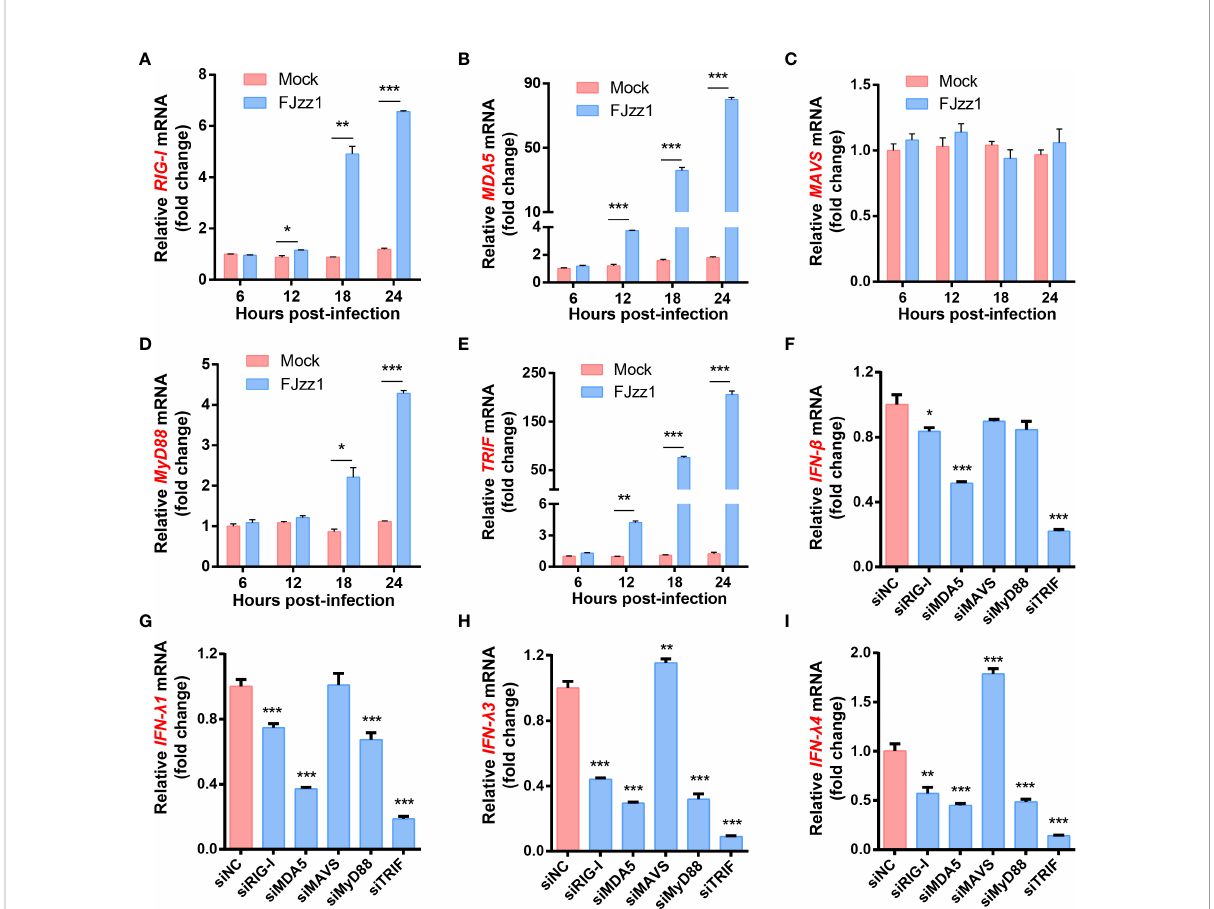
FIGURE 5 FJzz1 infection induced the production of type I/III IFNs through RLRs and TLRs signaling pathways. (A – E) FJzz1 infection increased the production of RIG-I, MDA5, MyD88, and TRIF. LLC-PK1 cells were infected with FJzz1 at an MOI of 0.01, and total cellular RNA was prepared at the indicated times post-infection to determine the mRNA level of RIG-I (A) , MDA5 (B) , MAVS (C) , MyD88 (D) , and TRIF (E) by RT-qPCR. (F – I) RLRs and TLRs signaling pathways mediated in the production of type I/III IFNs. LLC-PK1 cells were transfected with 80 nM speci fi c siRNA targeting RIG-I, MDA5, MAVS, MyD88, TRIF, or an NC siRNA for 24 h, and then cells were mocked or PEDV-infected (MOI=0.01). At 18 hpi, total cellular RNA was extracted to determine the mRNA level of IFN- b (F) , IFN- l 1 (G) , IFN- l 3 (H) , and IFN- l 4 (I) by RT-qPCR. These data are representative of the results of at least two independent experiments and error bars represent standard deviations. Asterisks indicate statistical signi fi cance.*, P < 0.05; **, P < 0.01; ***, P <